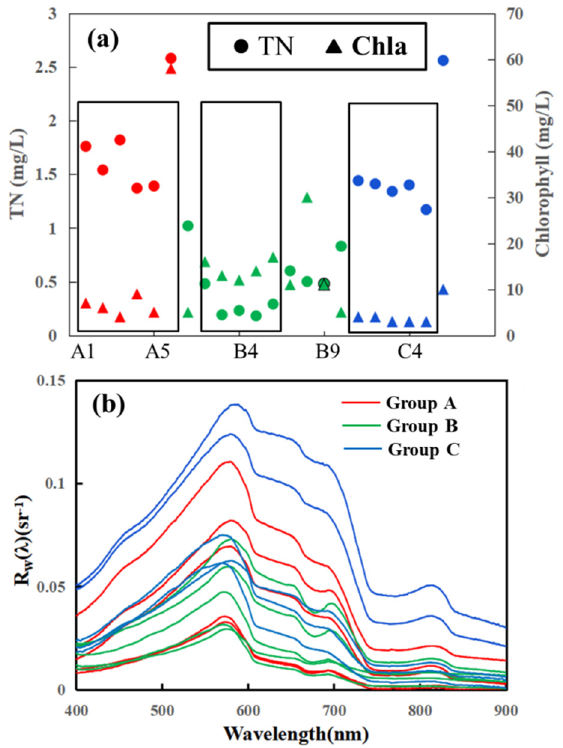
Figure 6. Measured concentration and spectral curves of sampling sites. ( a ) TN and chlorophyll concentration of typical sampling sites. The horizontal coordinates are the point numbers. ( b ) Spectral curves of typical sites in black boxes in ( a ), including A1–A5, B2–B6, and C1–C5. The red lines are the spectral curves of A1–A5 in ( a ). The green lines are the spectral curves of B2–B6 in ( a ). The blue lines are the spectral curves of C1–C5 in ( a